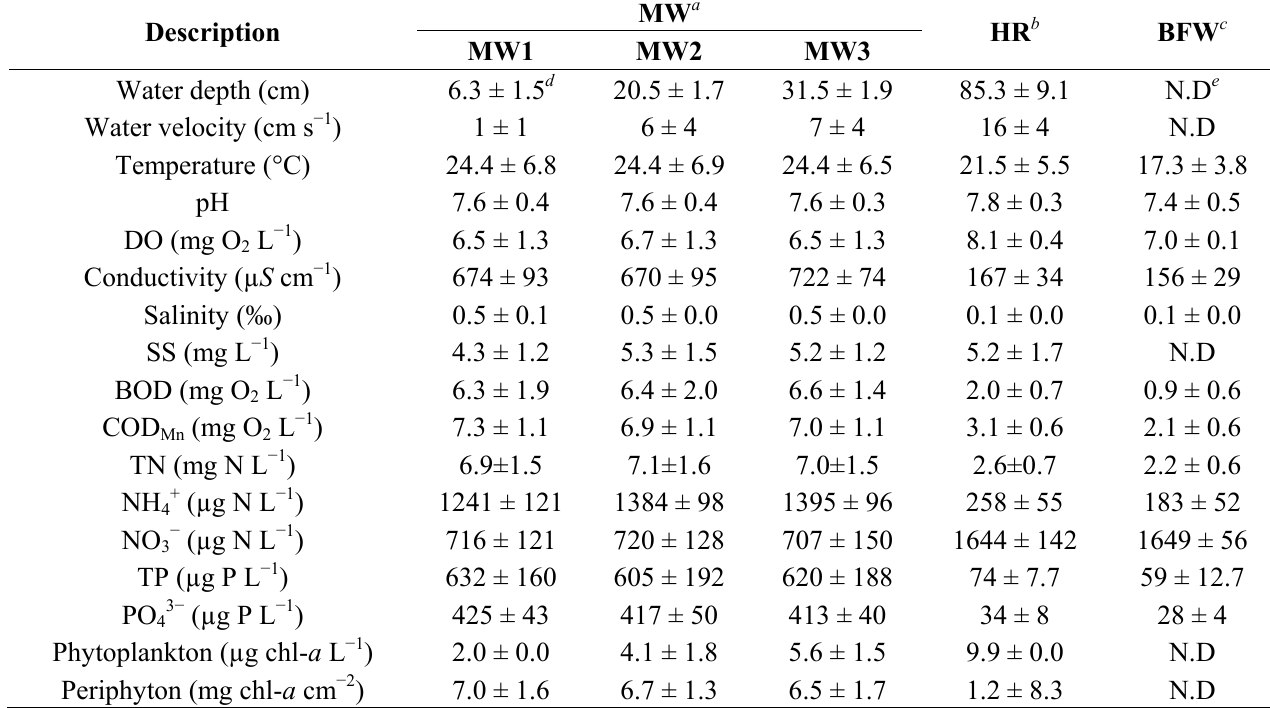
Table 1. Summary of annual water quality analysis results for three water sources from January to December in 2010 (n =